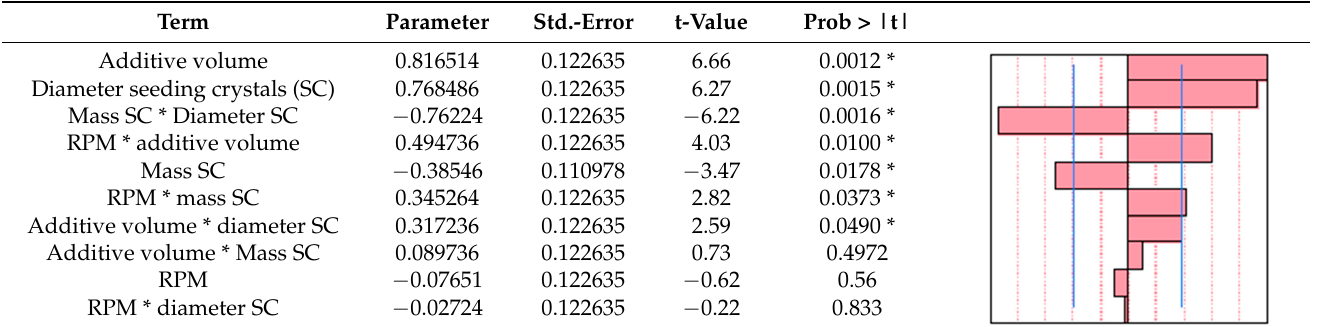
Table 3. Parameter influence on the crystal size ( 𝑥 (cid:2874)(cid:2871) (cid:4667) . The terms marked with a star (*) are statisti ‐ cally significant.